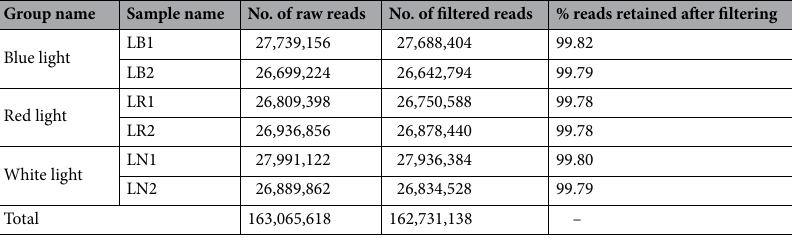
Table 1. Summary of raw data after trimming and filtering. LB: blue light; LR: red light; LN: white light.